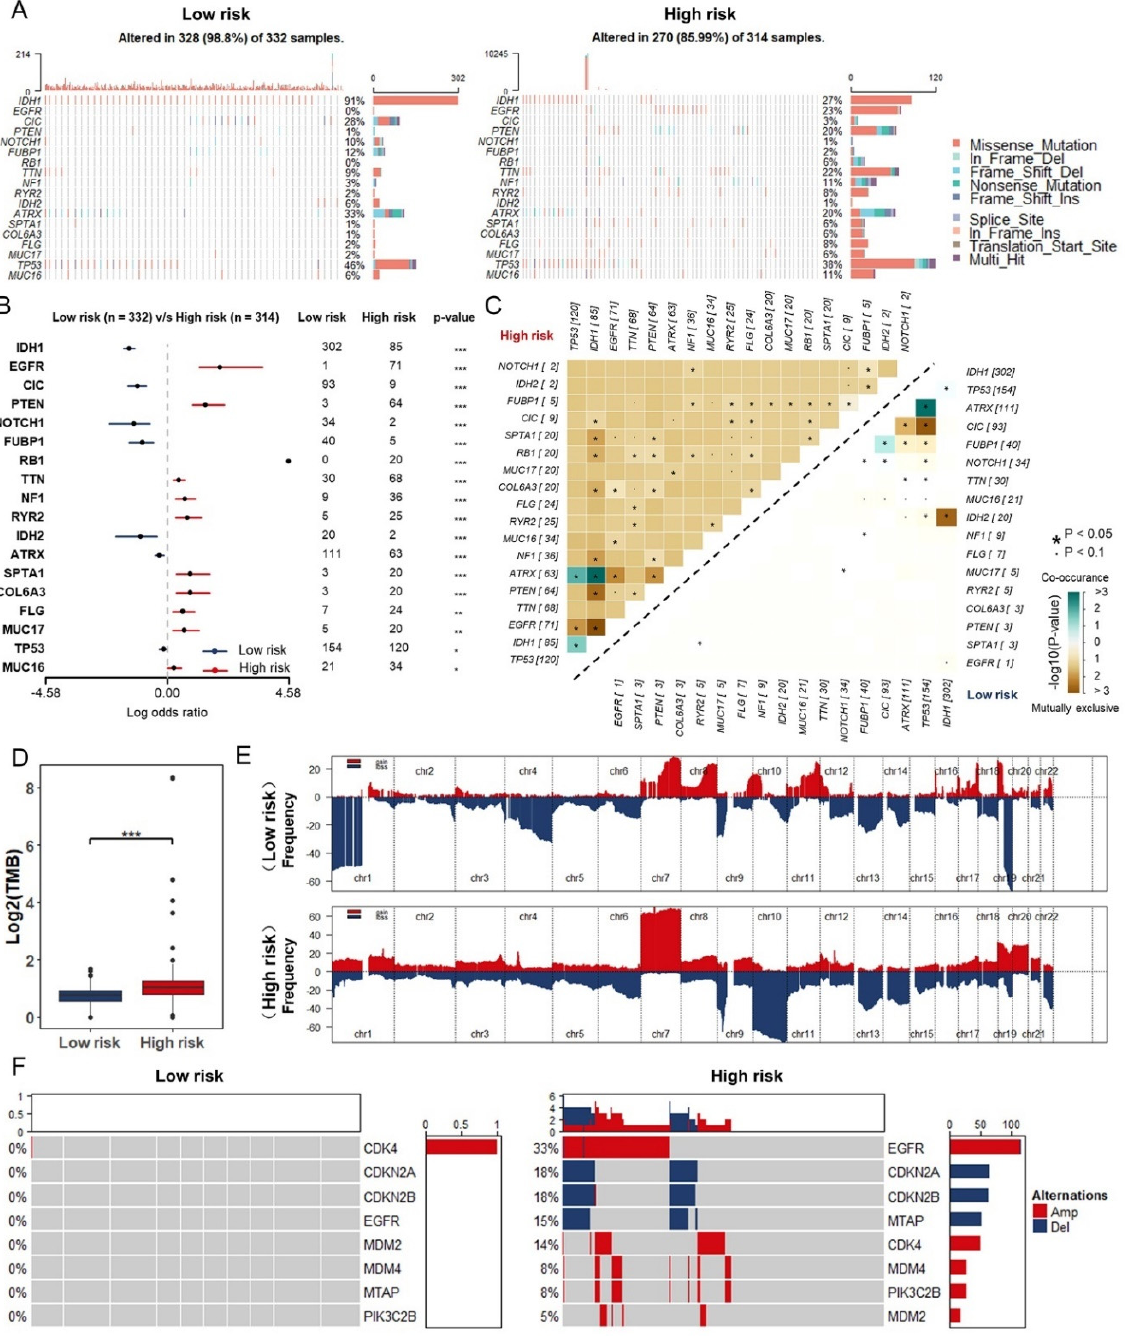
Figure 7. Somatic mutation and CMVs in different risk groups: ( A ) Heatmap of somatic mutations in different risk groups. ( B ) The differently mutated genes between low- and high-risk groups. ( C ) Heatmap of co-occurrence and mutually exclusive mutations of the differently mutated genes in low- and high-risk group. ( D ) TMB in low- and high-risk groups in TCGA database. ( E ) Detection and comparison of significant amplifications and deletions of copy number between low- and high-risk group. ( F ) Comparison of CNVs between low- and high-risk groups in TCGA database. *, p < 0.05; **, p < 0.01; ***, p < 0.001.